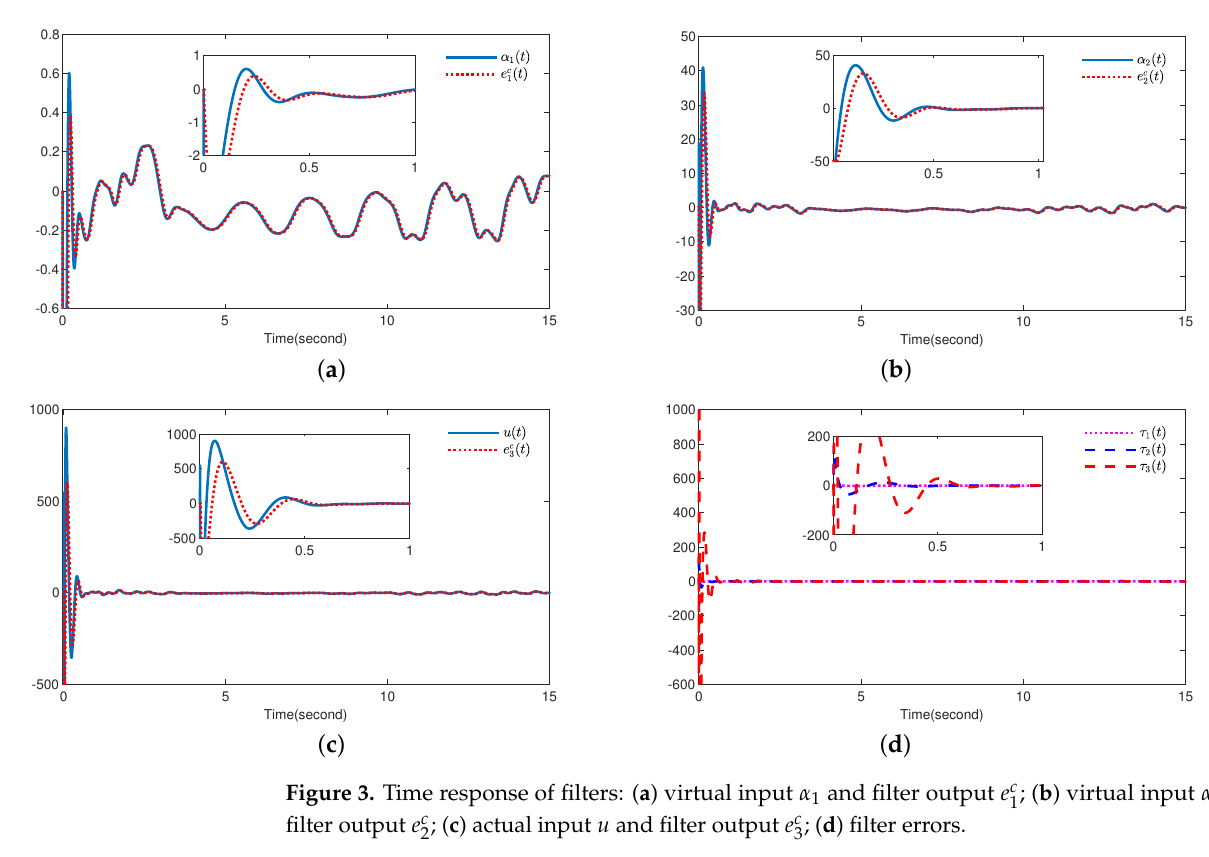
; ( b ) virtual input α 2 and 1 ; ( d ) filter errors. 3